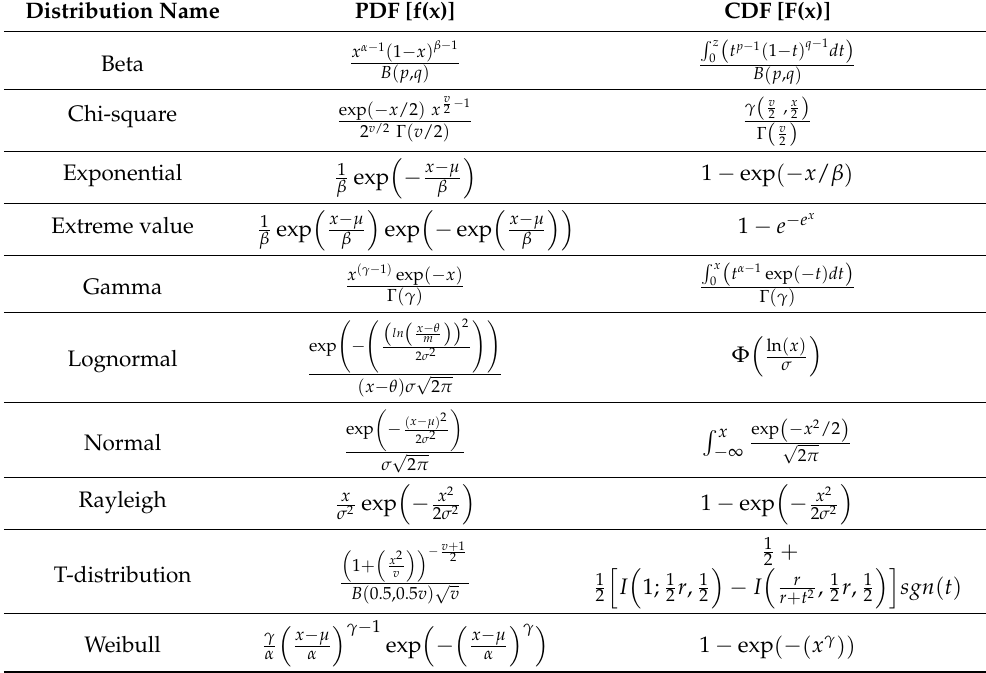
Table 5. Distributions considered with their respective PDF and CDF. Source: own elaboration based on